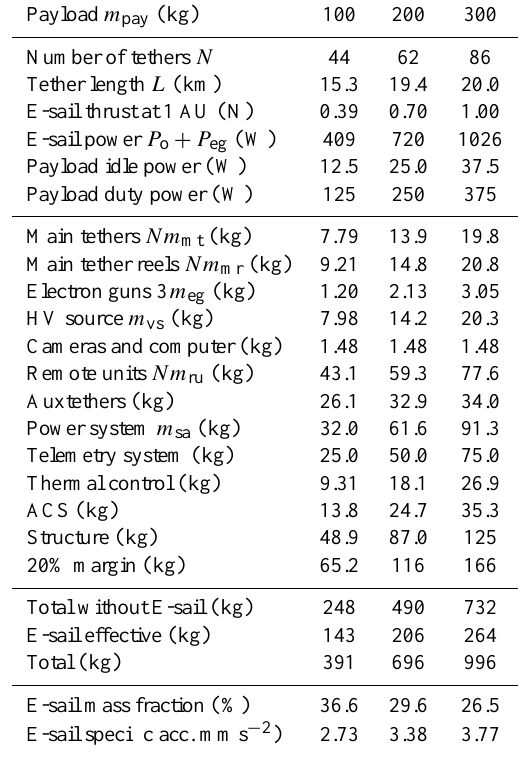
Table 3. Same as Table 2, but for a characteristic acceleration a ⊕ = 0 . 3mms − 2 .